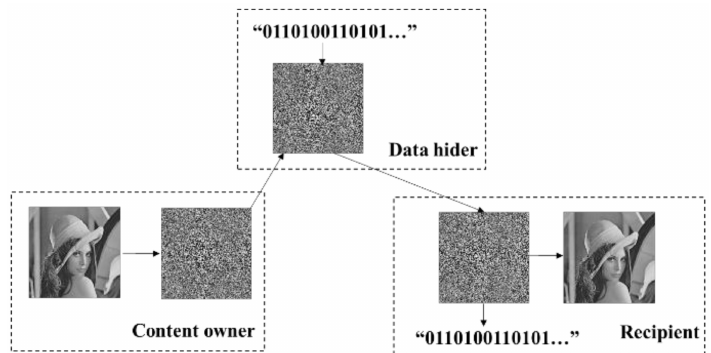
Figure 1. Tripartite relationship of the proposed method.